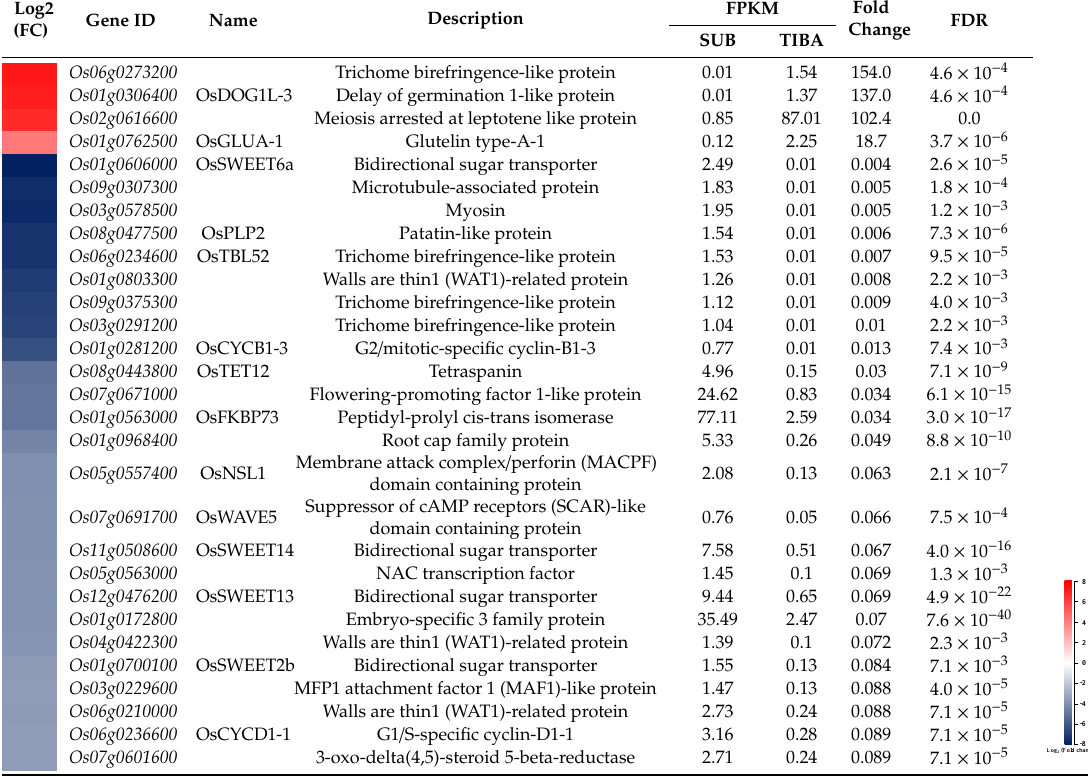
Table 3. The differentially expressed genes of development responsive were compared with submergence (SUB) and submergence with 10 μM TIBA (SUB + TIBA) in rice